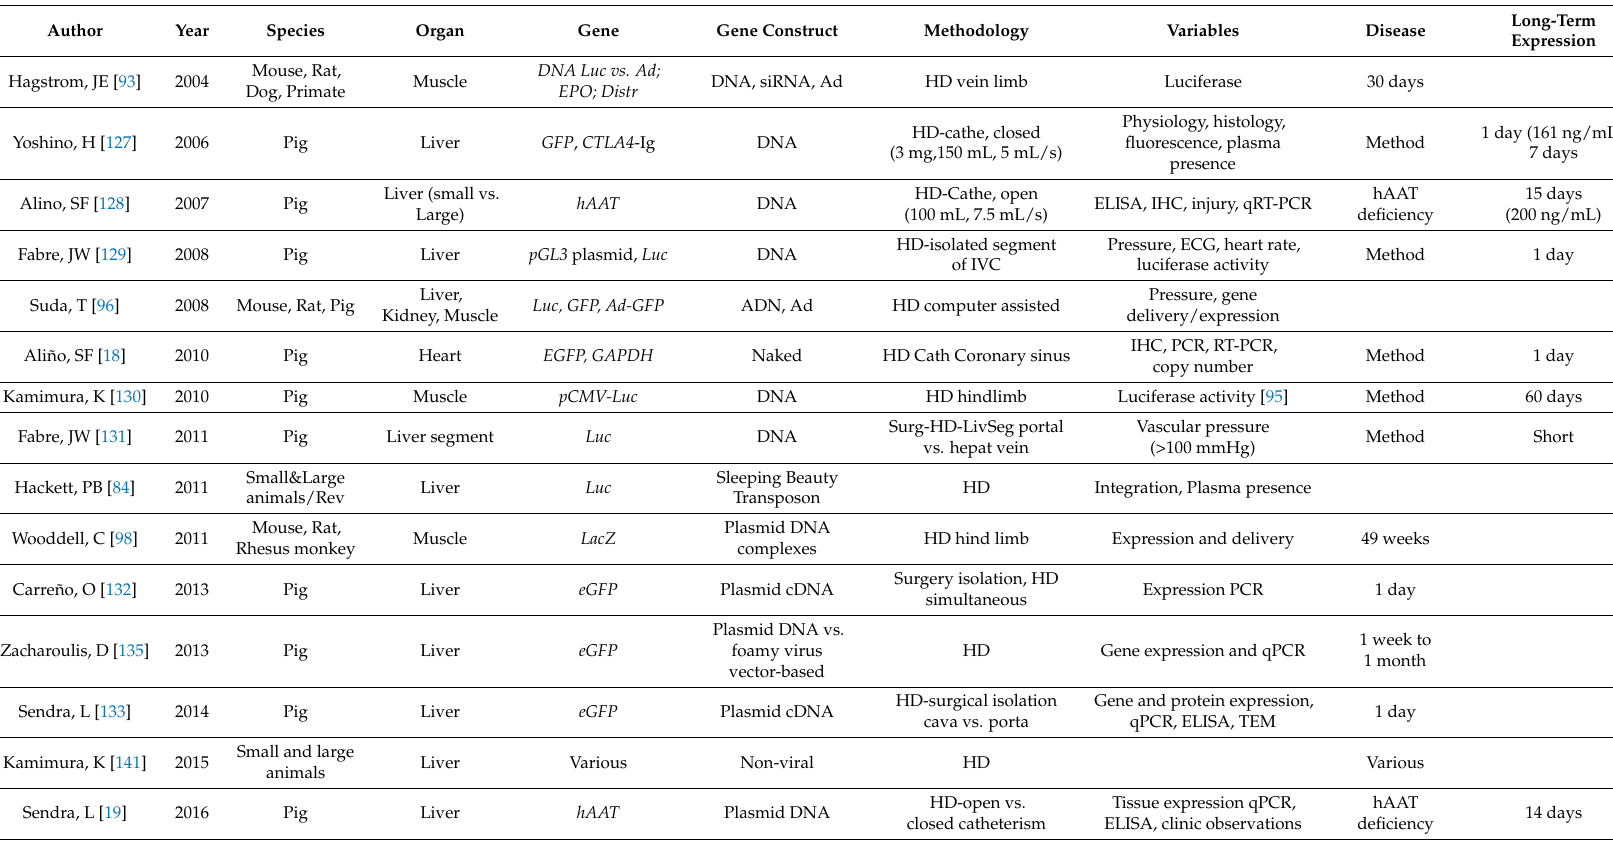
Table 3. Hydrodynamic gene transfer works performed in large animals. The table shows the author of each work, the publication year, the animal model studied, the target organ assayed, gene and gene construction, injection methodology, variables evaluated, disease of interest and effect